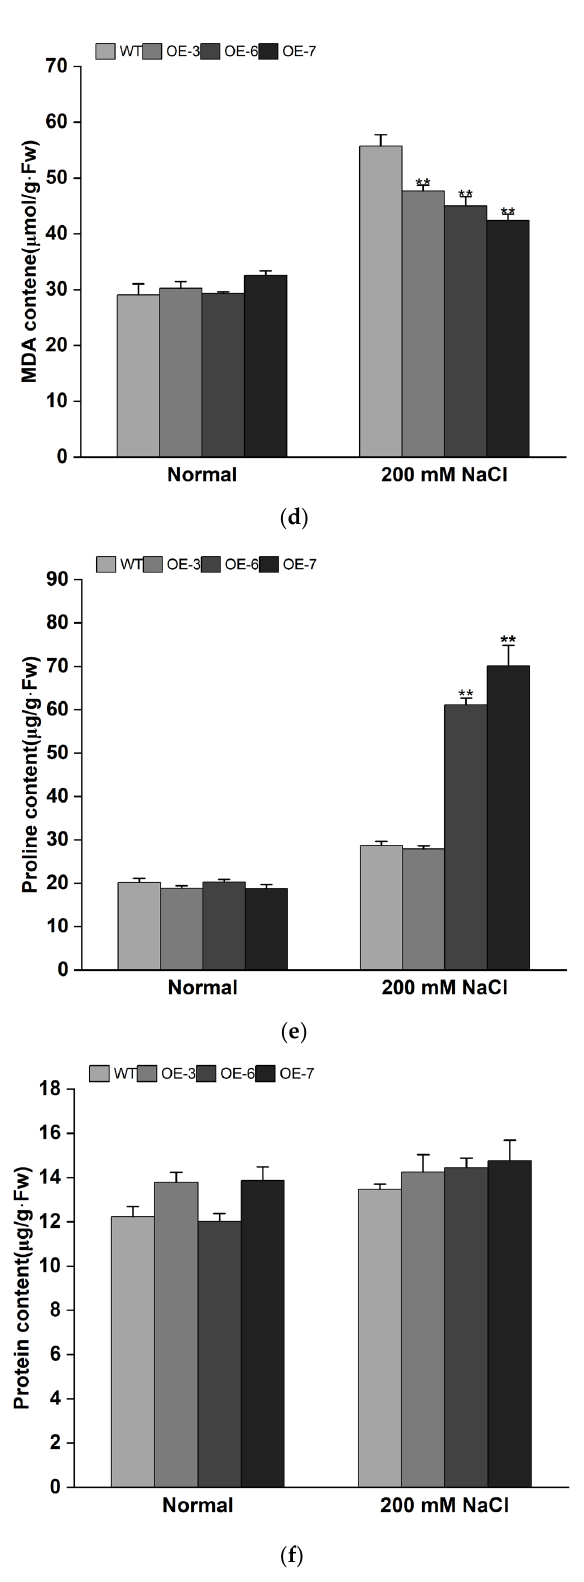
Figure 6. IbMYB308 improves salt tolerance in transgenic tobacco plants. ( a ) Performance of IbMYB308 transgenic tobacco and WT cultured for four weeks on MS medium without stress or with 200 mM NaCl. ( b ) CAT activity. ( c ) POD activity. ( d ) MDA content. ( e ) Proline content. ( f ) Protein contents of OE-lines and the WT under normal and 200 mM NaCl treatments. Data are presented as the means of three biological replicates ± SD ( n = 3 ). * and ** indicate significant differences at p < 0.05 and p < 0.01, respectively.